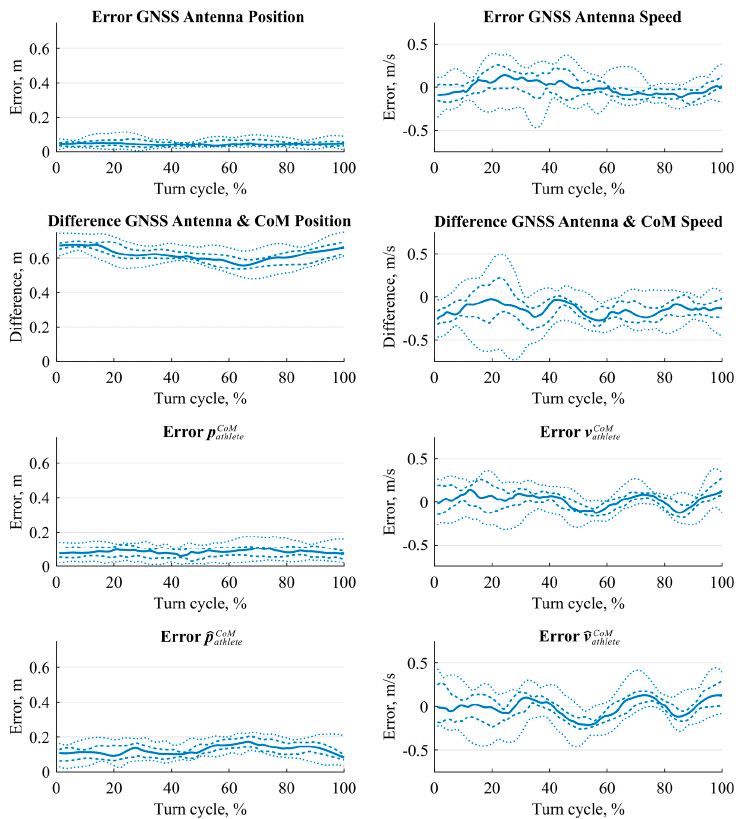
bottom to top, the 5th (dotted), 25th (dashed), 50th (solid), 75th (dashed), and 95th (dotted) percentiles. Remote Sens. 2016 , 8 , 671